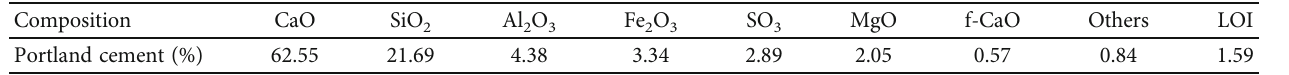
Table 2: Chemical composition of common Portland cement (P.O